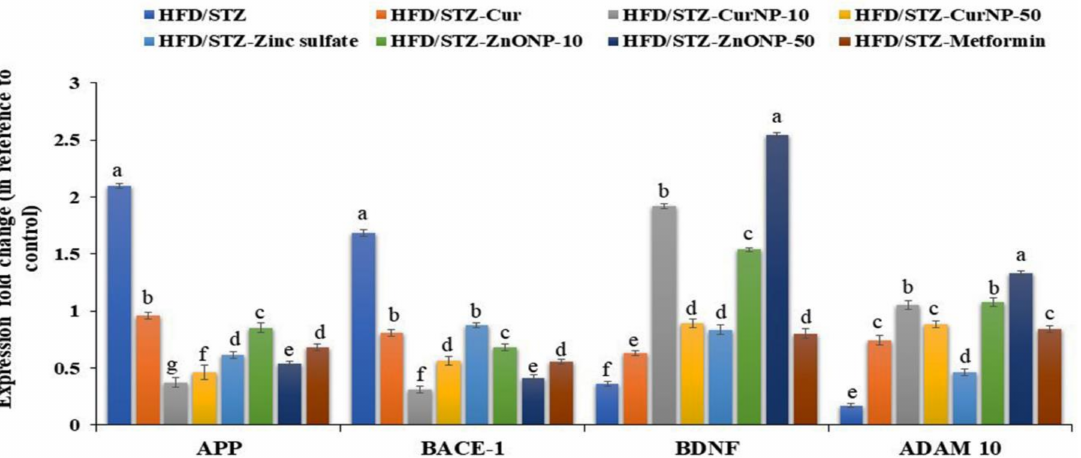
Figure 3. Gene expression profile of APP, BACE-1, BDNF, and ADAM-10 in the hippocampus of rats. Data are expressed as mean ± SEM ( n = 3); means for the same parameter with different letters (a–g) in each bar are significantly different ( p < 0.01), the largest data value takes the letter (a) and the smallest data value takes the letter